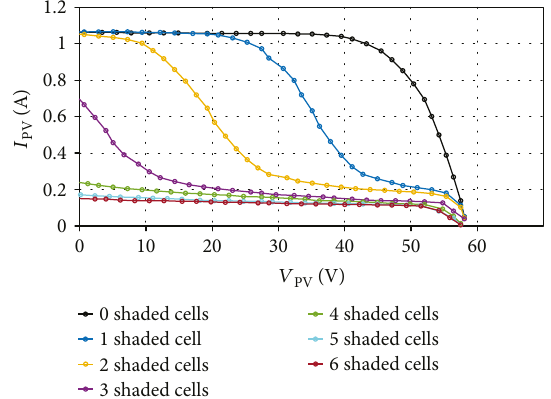
Figure 16: Experimental set-up adopted for tracing I - V and P - V characteristics both for positive and negative = 26 ° C . amb